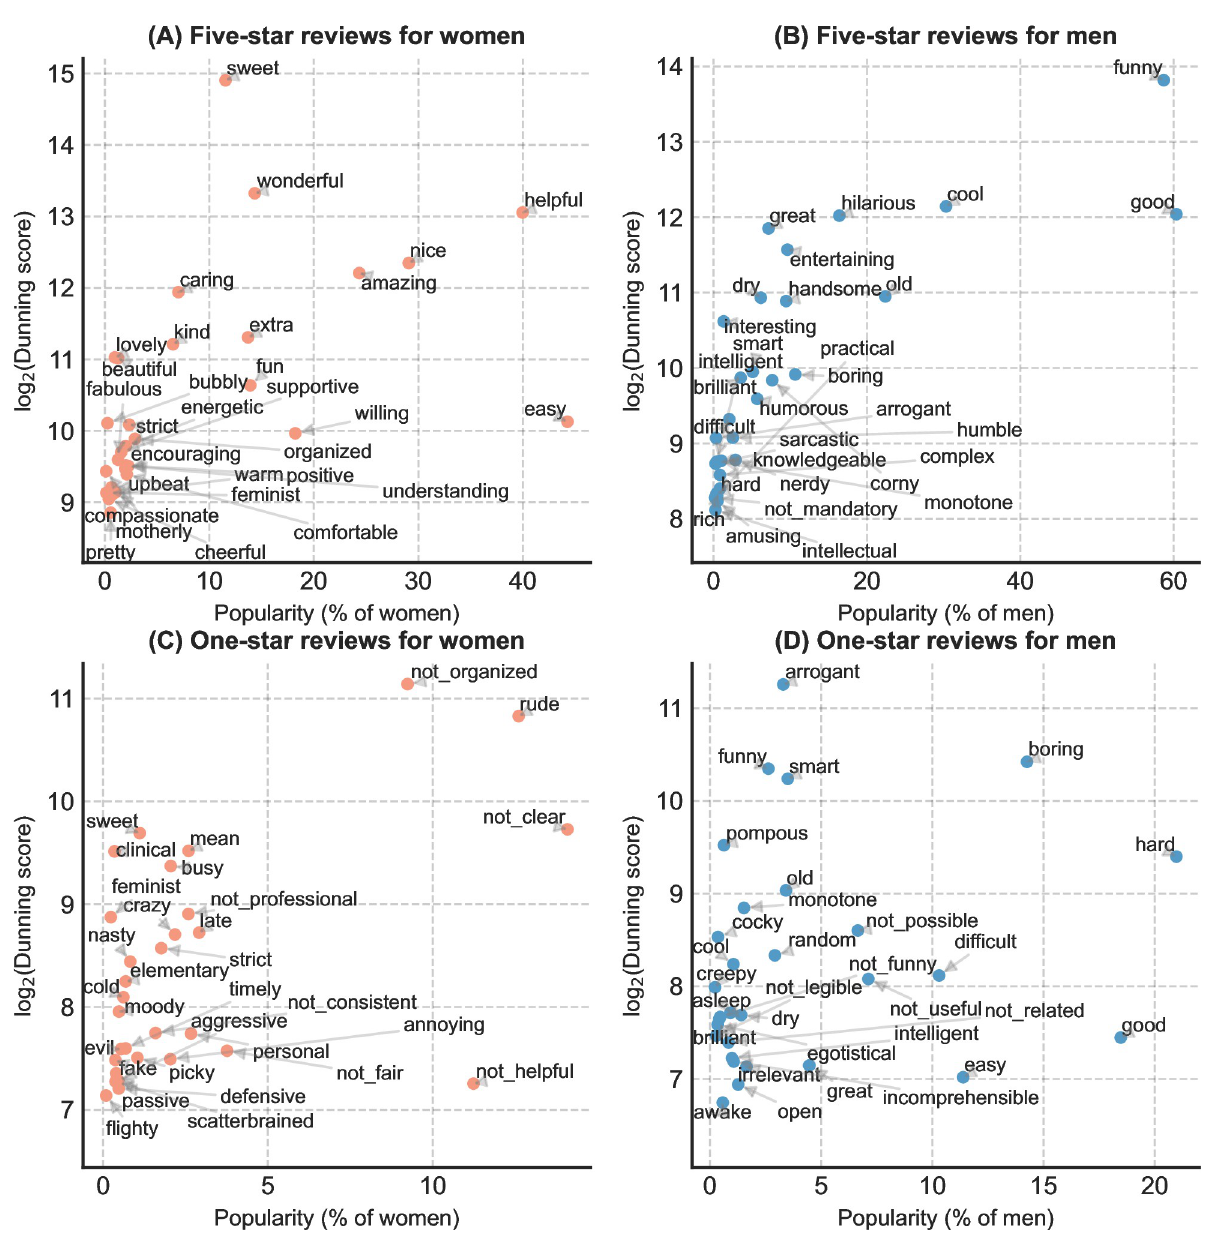
Fig 5. Dunning score and popularity of the top 30 gender-distinct adjectives in RMP comments by gender and rating. The popularity of a word is the percentage of professors whose comments contain the word. (A) In five-star reviews for women. (B) In five-star reviews for men. (C) In one-star reviews for women. (D) In one-star reviews for